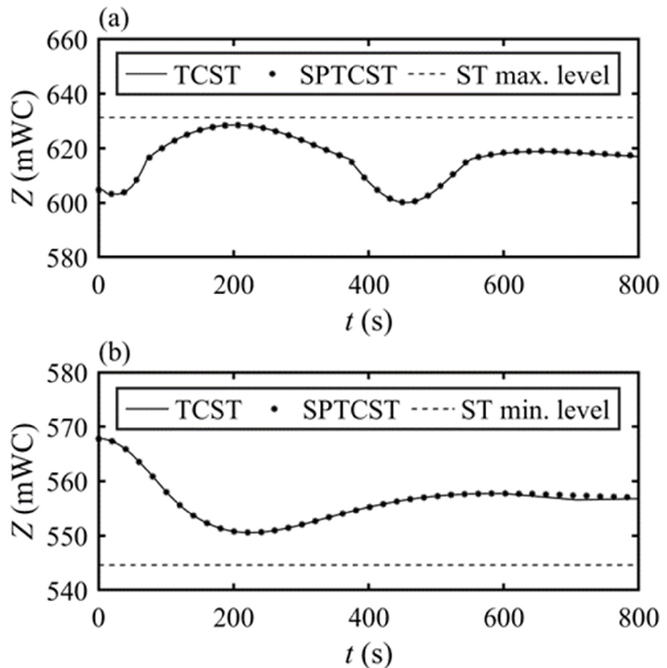
Figure 4. STWL of the throttled chamber and semi-pneumatic throttled chamber surge tank for ( a ) load rejection and ( b ) simultaneous start of both turbines.